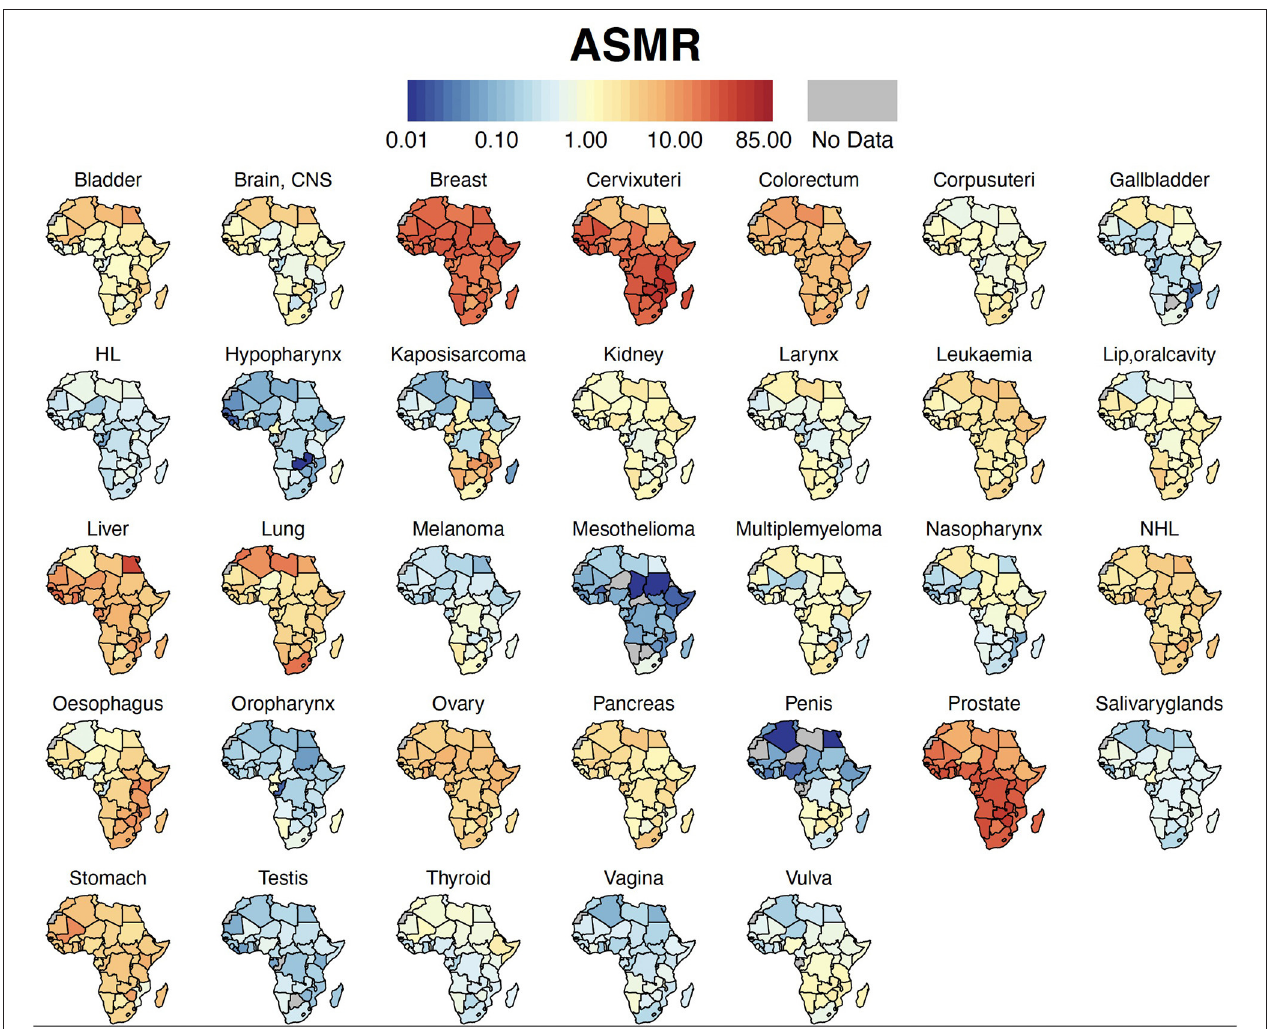
FIGURE 2 | Country-specific ASMR. Cancer ASMR per 100,000 for each country in Africa. ASMR, Age-standardized Mortality Rate; HL, Hodgkin Lymphoma; NHL, Non-Hodgkin Lymphoma, CNS, Central Nervous